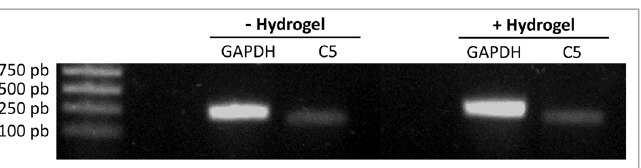
Figure 6. Complement C5 expression by endothelial cells. RT ‐ PCR analysis of C5 mRNA expression shows that HUVECs express C5 mRNA whether incubated with the hydrogel or not. GAPDH was used as a housekeeping control.